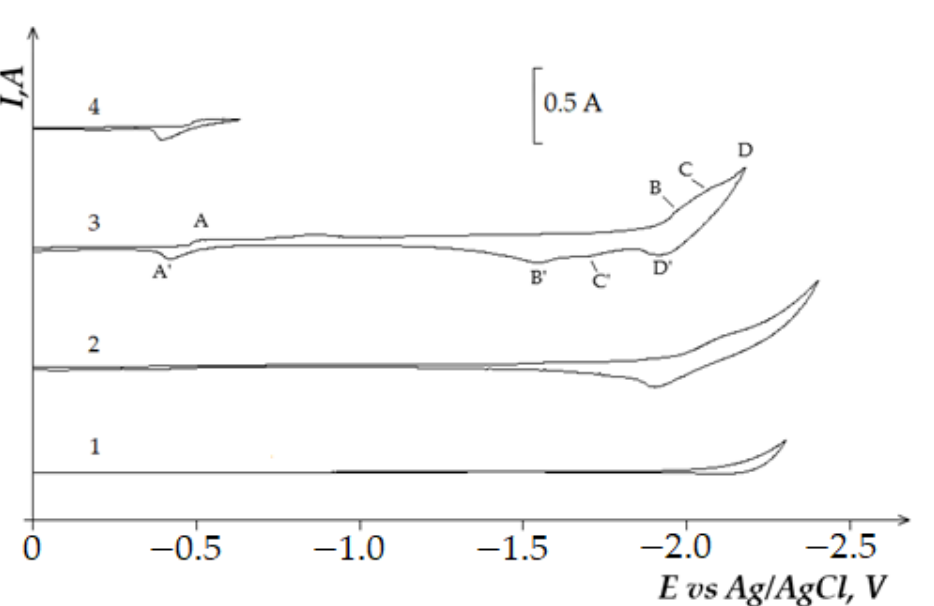
Figure 13. Cyclic voltammograms of electrochemical coreduction of Dy 3+ and Fe 3+ ions on the tungsten electrode in the equimolar KCl-NaCl melt at 973 K, polarization rate of 0.2 V/s, and different reverse potentials: curve 1 ( − 2.3 V), curve 2 ( − 2.4 V), curve 3 ( − 2.2 V), curve 4 ( − 0.62 V). Concentration of DyCl 3 : curve 1—0 mol/cm 3 , curves (2–4)—3.0 × 10 − 4 mol/cm 3 . Concentration of FeCl 3 : curves (1 and 2)—0 mol/cm 3 , curves (3 and 4)—5.0 × 10 − 5 mol/cm 3 . The wave of dysprosium chloride DyCl 63 − complex’s extraction shifts insignificantly